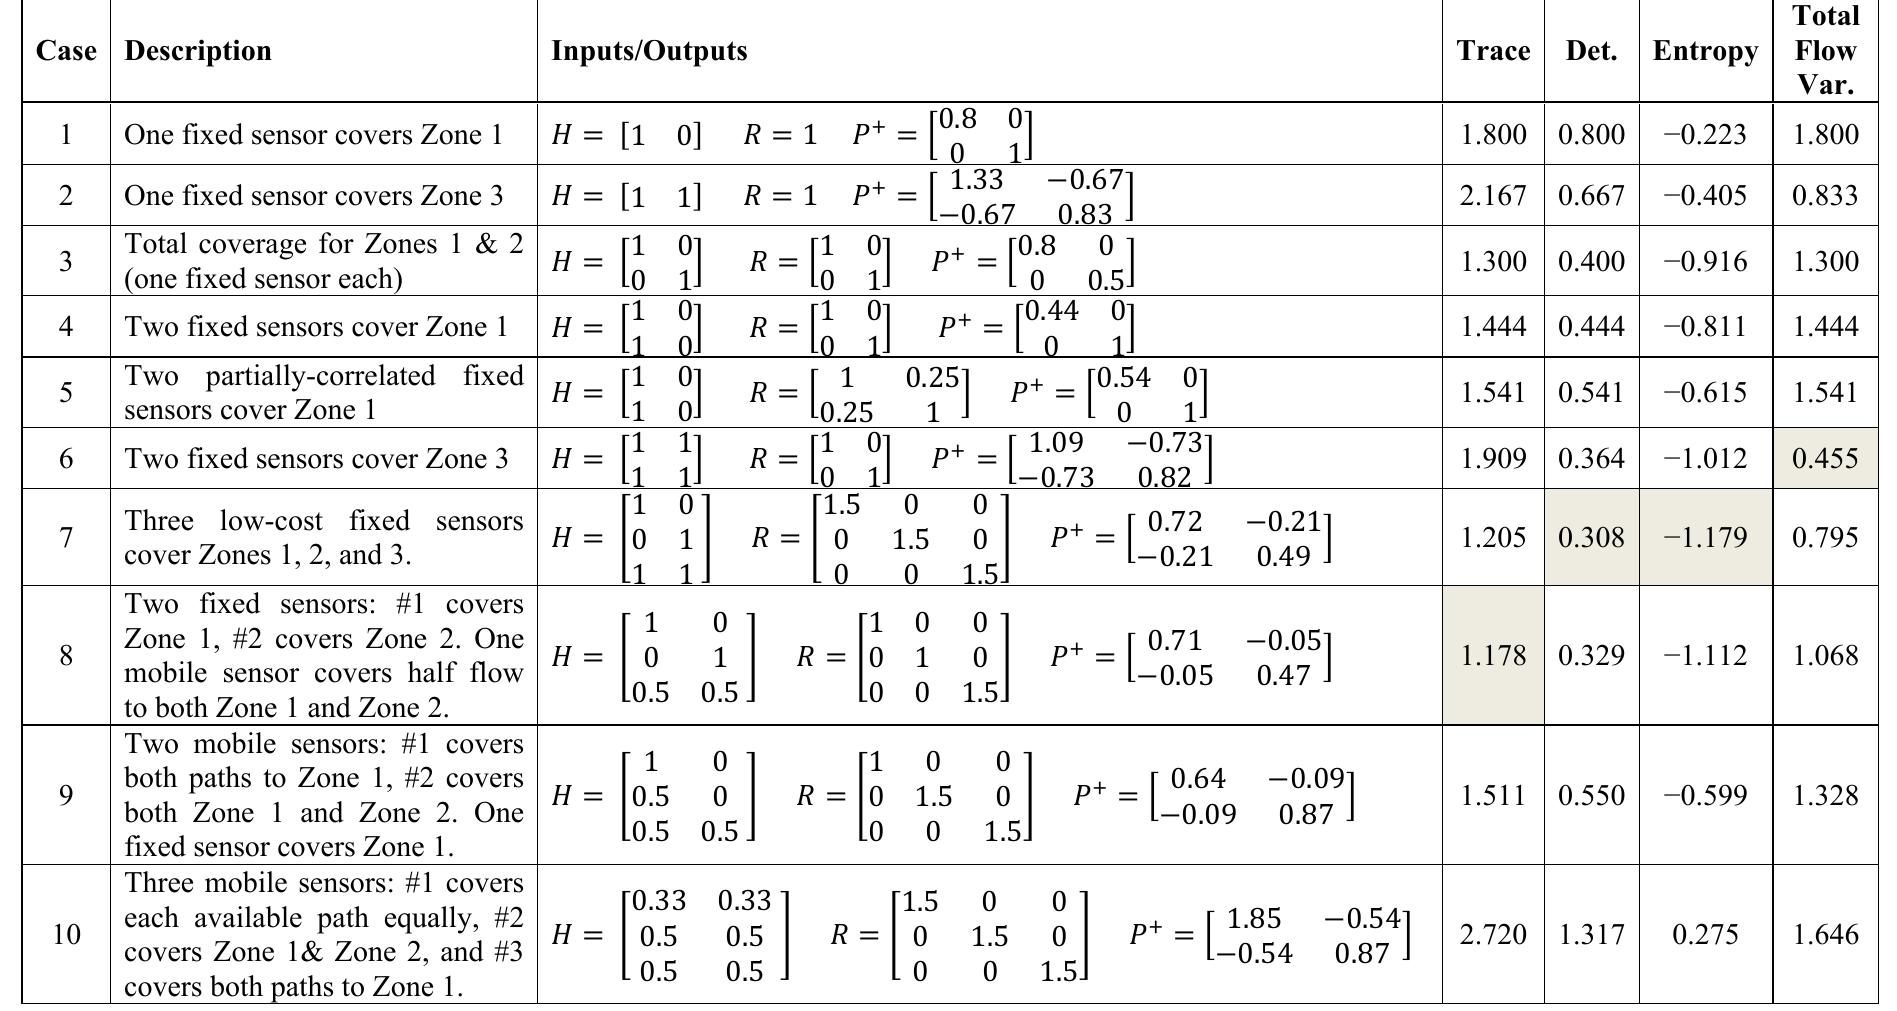
Table 2. Example descriptions, intermediate steps, and calculation results.